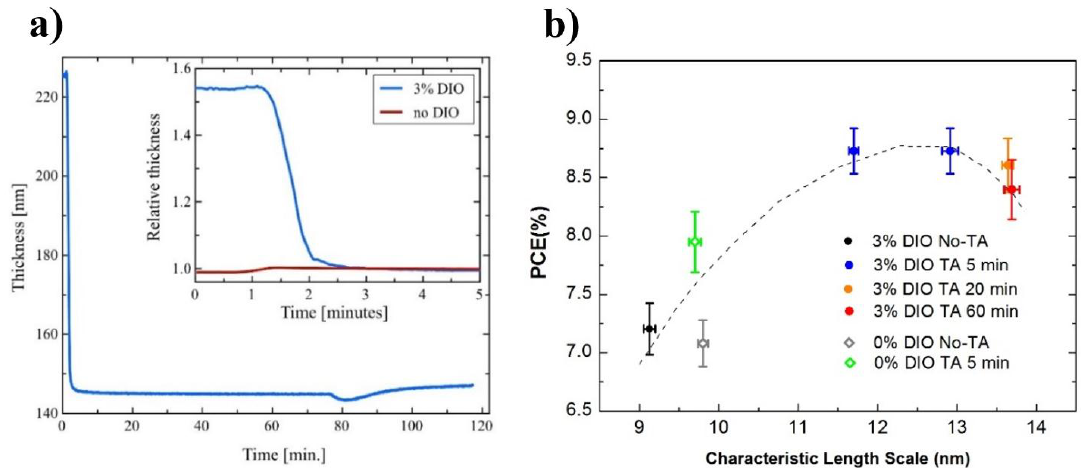
Figure 7. ( a ) Dynamic spectroscopic ellipsometry data for the isothermal annealing of a PffBT4T-2OD:PC 71 BM blend film annealed at 100 °C. The heating stage was at 100 °C at time t = 1 min. The inset shows a zoomed in region at the beginning showing the dramatic drop in thickness within the first minute of being at temperature; ( b ) Correlation between PCE and characteristic length scale for samples processed in different ways, that is, with/without DIO and with/without annealing. Reprinted with permission from ref. [39].